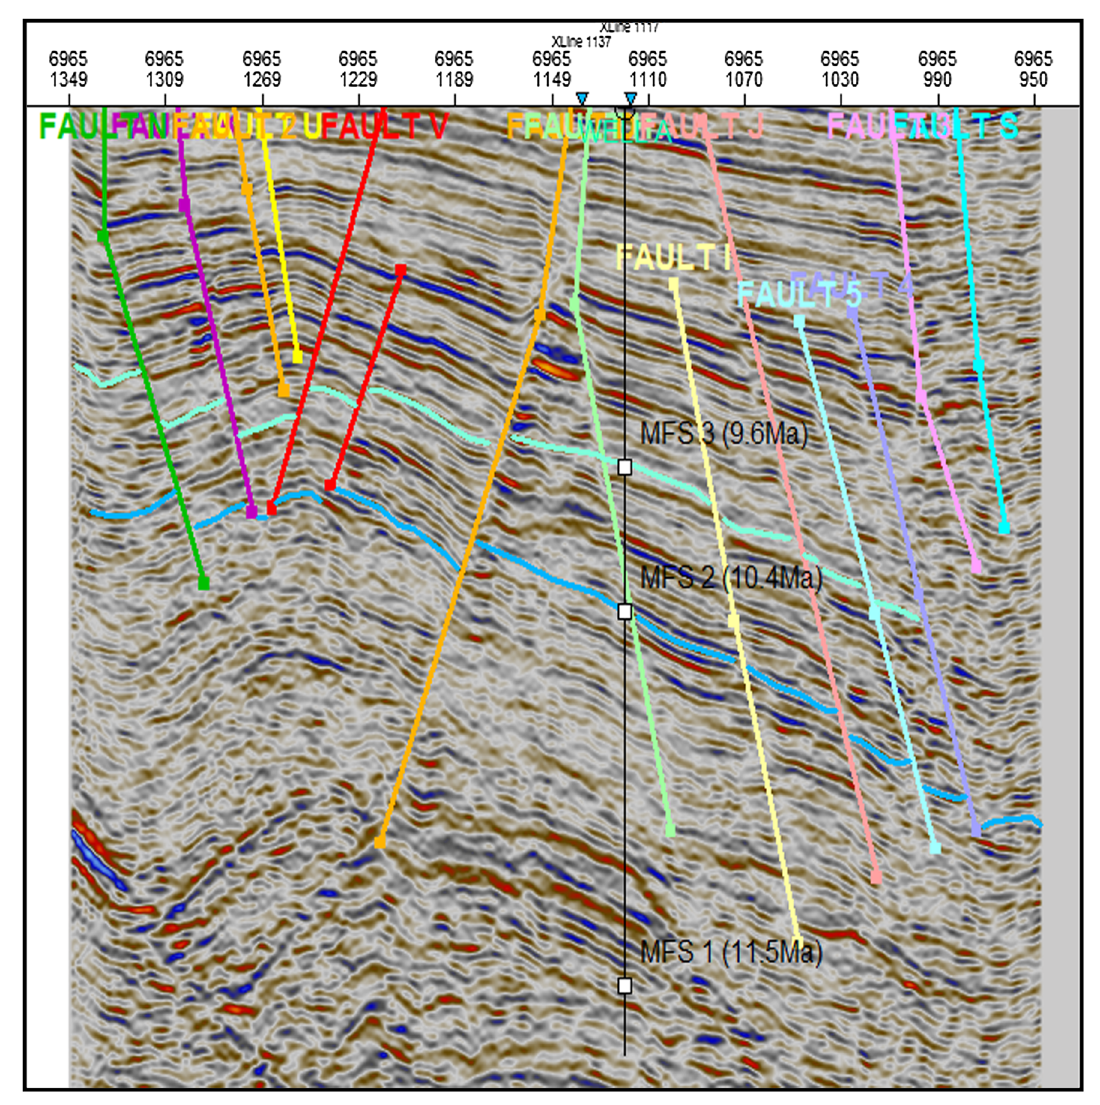
Fig. 8 Seismic cross section along Inline 6955 showing the horizon